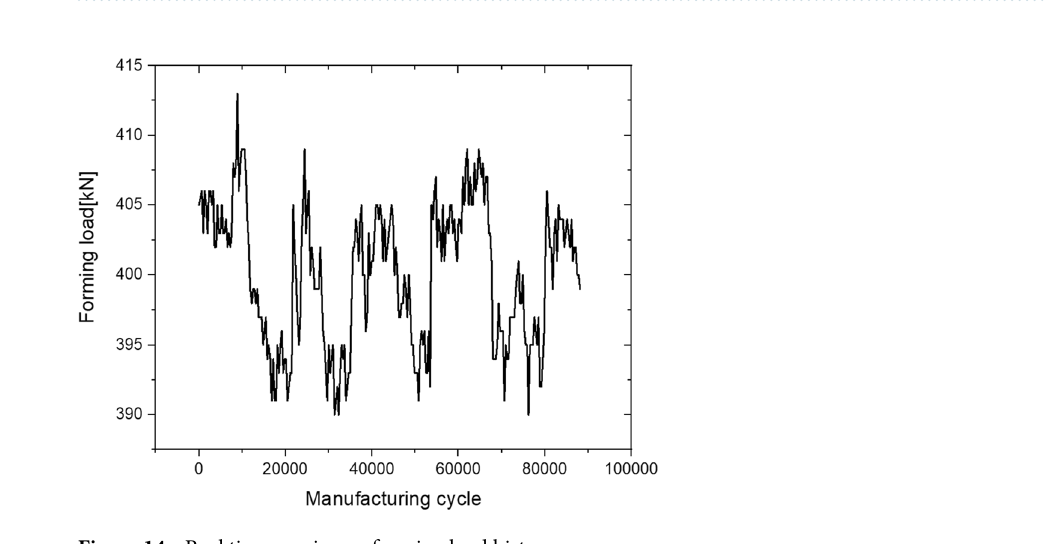
Figure 13. Predictive model based on maximum principle stress history.